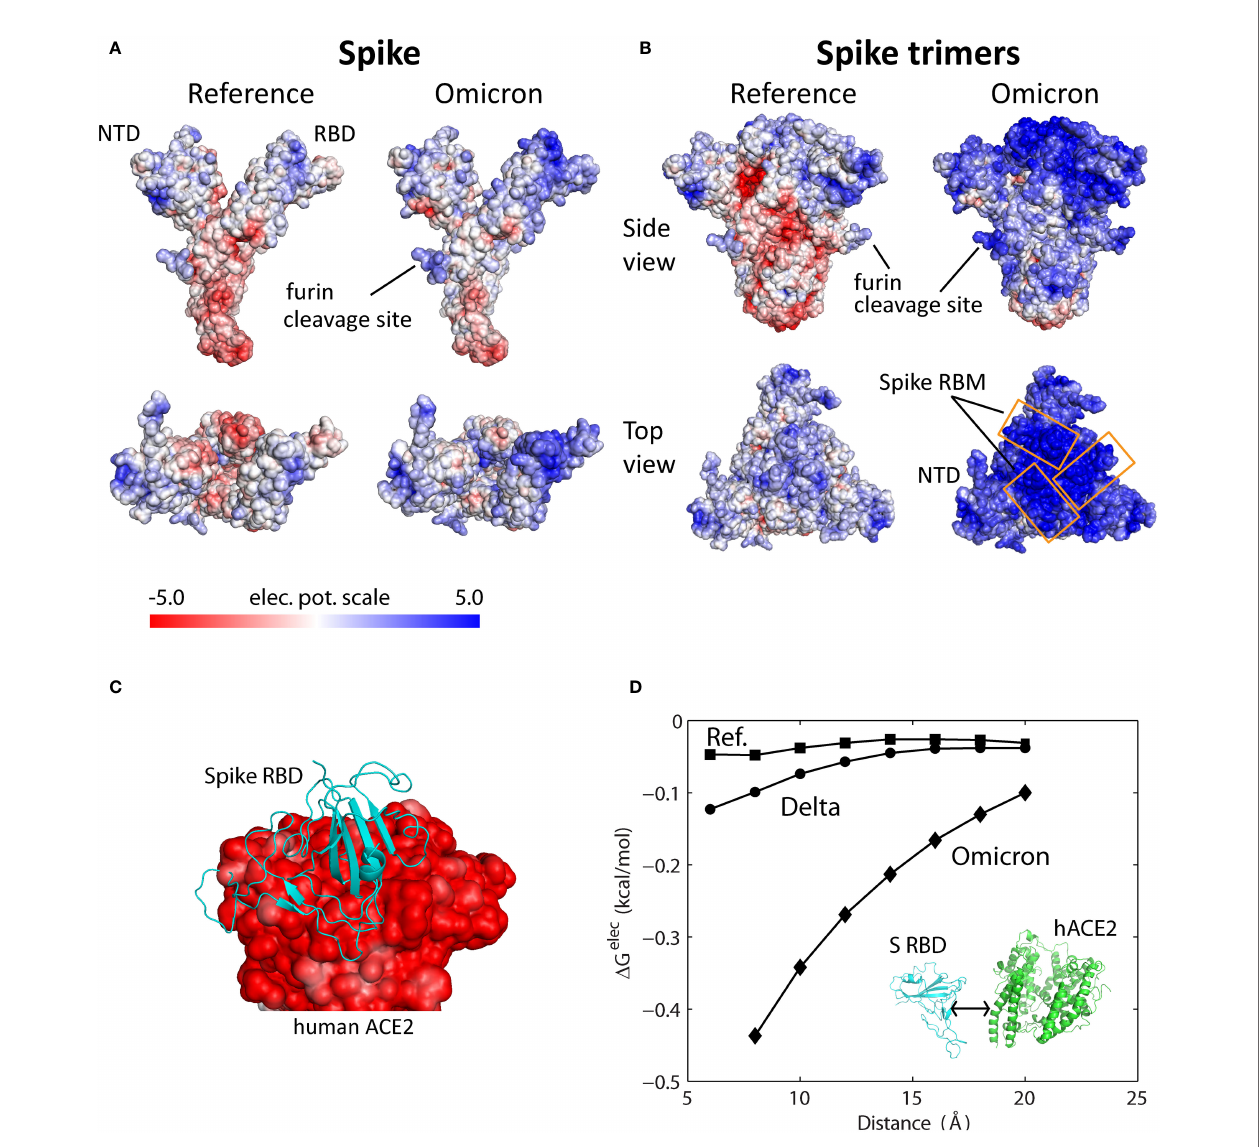
FIGURE 1 | Electrostatic potential surfaces of Spike, Spike trimer, and ACE2 proteins. (A) Electrostatic surfaces of reference and modeled Omicron Spike proteins. (B) Electrostatic surfaces of reference and modeled Omicron Spike trimers. (C) Electrostatic surface of extracellular domain of human ACE2 with Spike RBD (PDB ID: 6m17). (D) Electrostatic binding energy as a function of separation distance for the reference, Delta and Omicron Spike RBD-ACE2 complexes. Separation distance is along the axis perpendicular to the interaction interface. The color scale of the electrostatic potential surface is in units of kT/e at T = 37°C, or